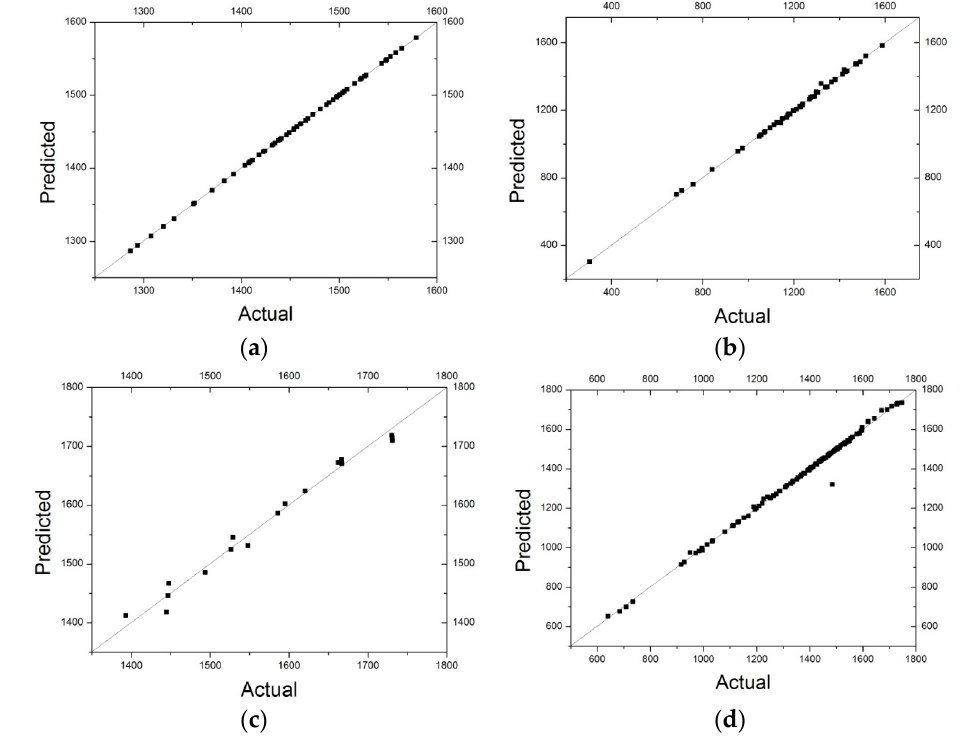
Figure 5. Predicted values versus actual values in testing processes using machine learning models. ( a ) The SVM for data provided by Fedele et al. [1]; ( b ) the SVM for data provided by Ihmels et al. [24]; ( c ) the MLFN-2 for data provided by Klomfar et al. [25]; and ( d ) the SVM for data provided by all the three experimental reports [1,24,25]. Table 5. RMSEs of different models.